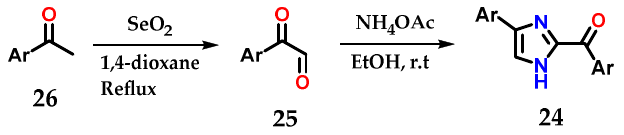
Figure 13. Obtaining disubstituted imidazoles 24 from aryl-methylketones 26 .